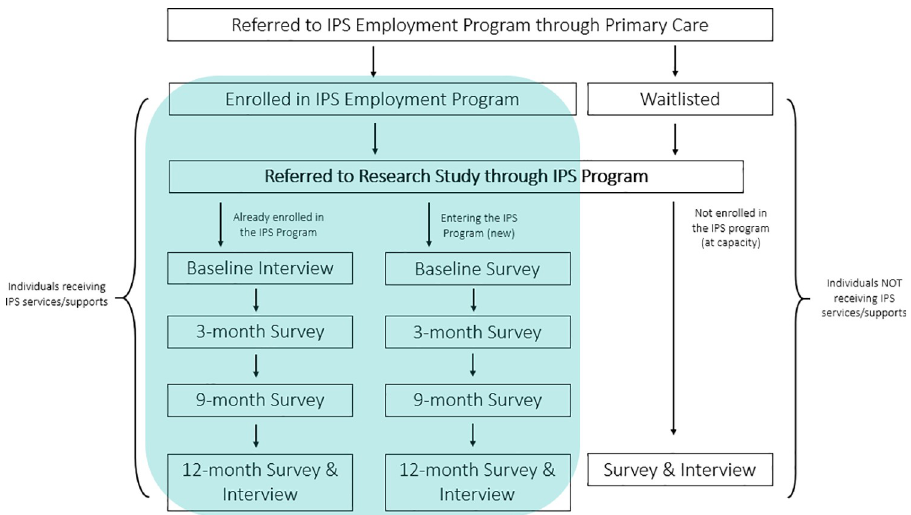
Fig 2. Study flowchart (individuals referred to the IPS employment